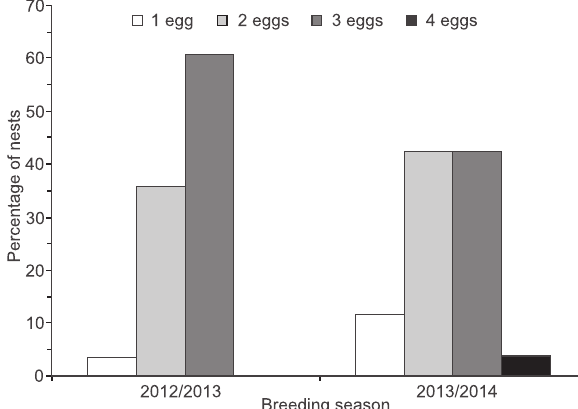
Figure 4. Clutch size of Tyrannus melancholicus at Setiba Environ- mental Protection Area, Brazil, during the breeding seasons of 2012/2013 and